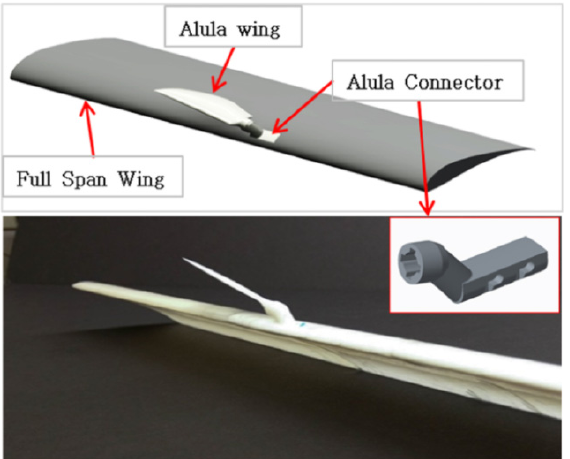
Figure 6. Schematic of the leading-edge alula device adopted by Mandadzhiev et al. [18,19].